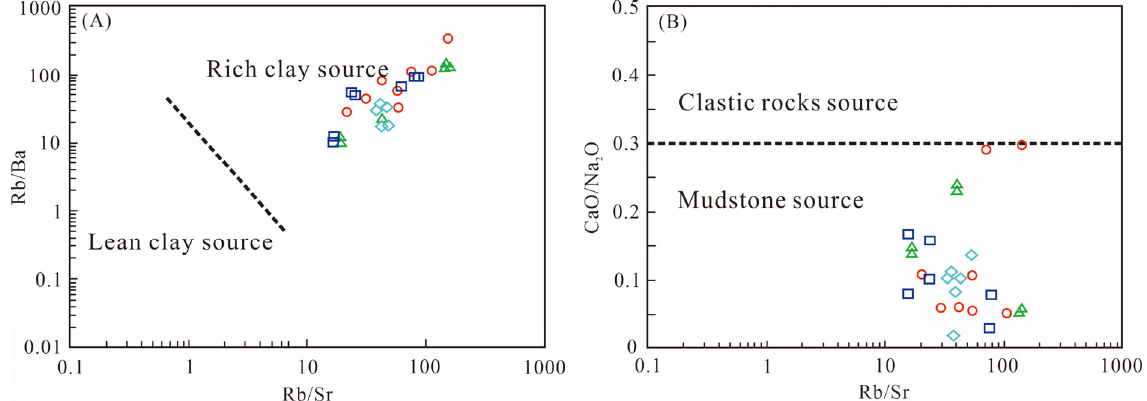
Figure 10. The Rb/Sr ‐ Rb/Ba diagram ( A ) and the Rb/Sr ‐ CaO/Na 2 O diagram ( B ) of the Helong granites. Symbols as in Figure 4.